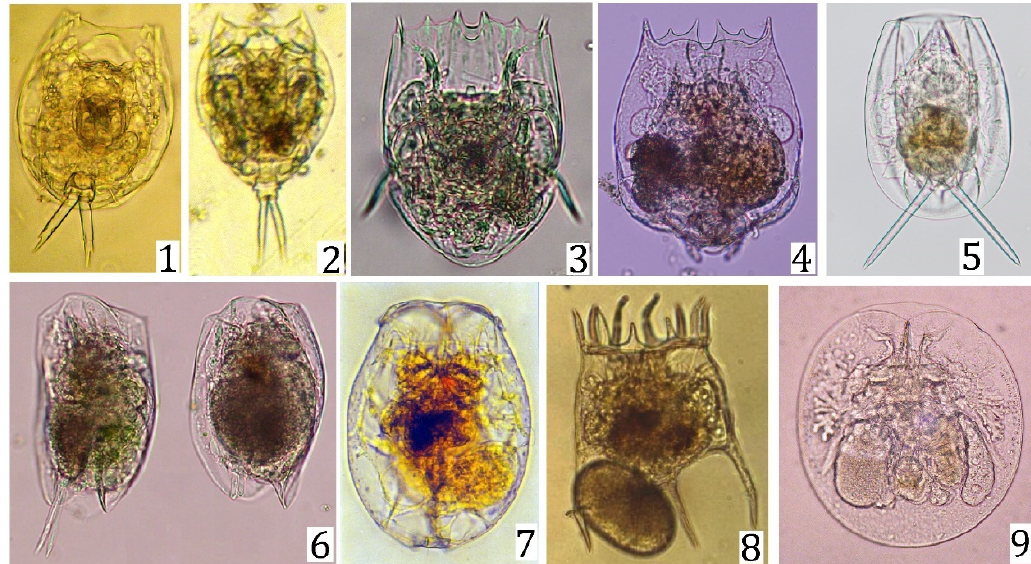
Figure 2. Some interesting rotifers from Mexico. ( 1 ) Lecane yatseni , ( 2 ) Lecane rhytida , ( 3 ) Notholca cf. liepetterseni , ( 4 ) Brachionus bidentatus , ( 5 ) Dipleuchlanis propatula ; ( 6 ) Euchlanis cf. mikropous , ( 7 ) Brachionus dimidiatus , ( 8 ) Plationus patulus macracanthus and ( 9 ) Testudinella patina . All photos from authors’ previous works.